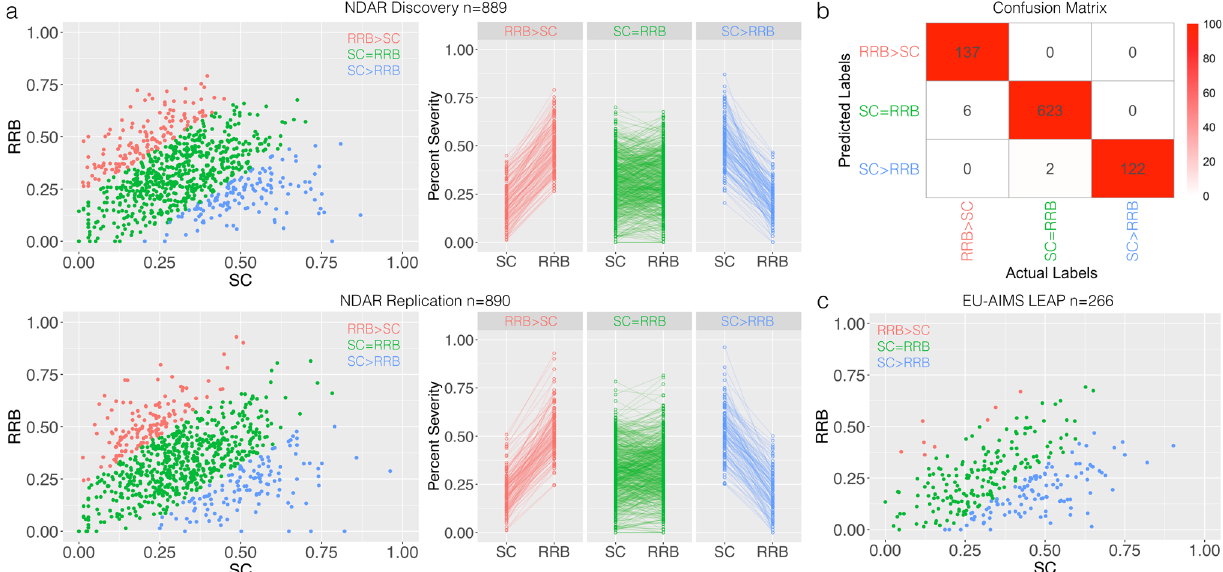
Fig. 2 Supervised subtyping of autism by SC-RRB balance. Panel ( a ) shows the subtypes derived from a z-normalized difference score of SC-RRB, with a z-score threshold for cutting the subtypes at z = 1. Red shows the RRB > SC subtype, green shows the SC = RRB subtype, and blue shows the SC > RRB subtype. Panel ( b ) shows a confusion matrix with actual subtype labels for the NDAR Replication dataset along with the columns and the subtyping model ’ s predicted labels (trained on the NDAR Discovery dataset) along the rows. The colors within the cells indicate the percentage of individuals relative to the actual labels with predicted labels in each cell. Over a range of z-thresholds from 0.5 to 1, the accuracy ranged from 97 – 99% accuracy. Panel ( c ) shows SC-RRB subtypes from the EU-AIMS LEAP datasets derived using norms estimated from NDAR.